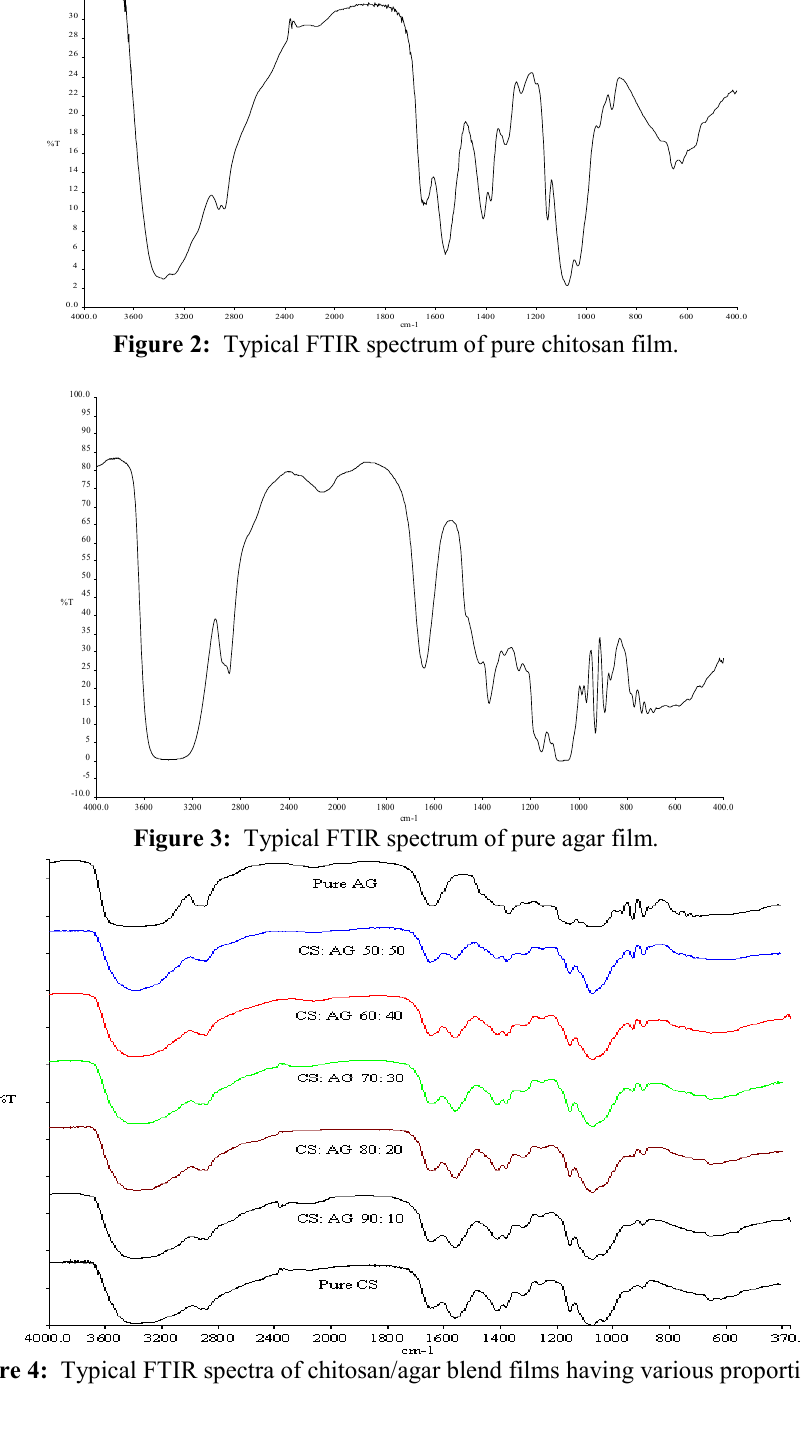
Figure 4: Typical FTIR spectra of chitosan/agar blend films having various